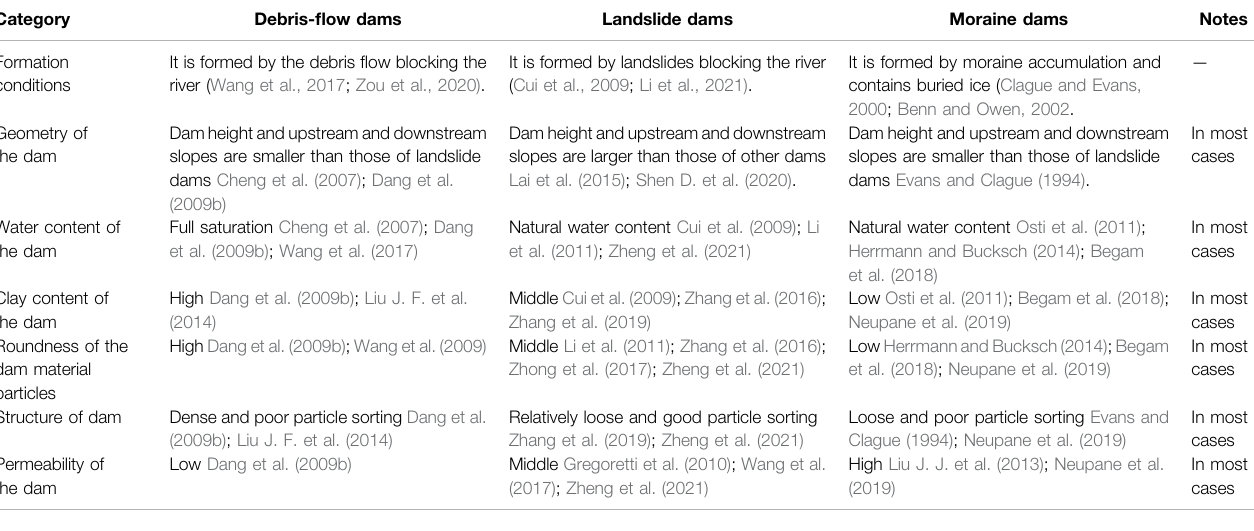
TABLE 4 | Comparing different types of barrier dams.